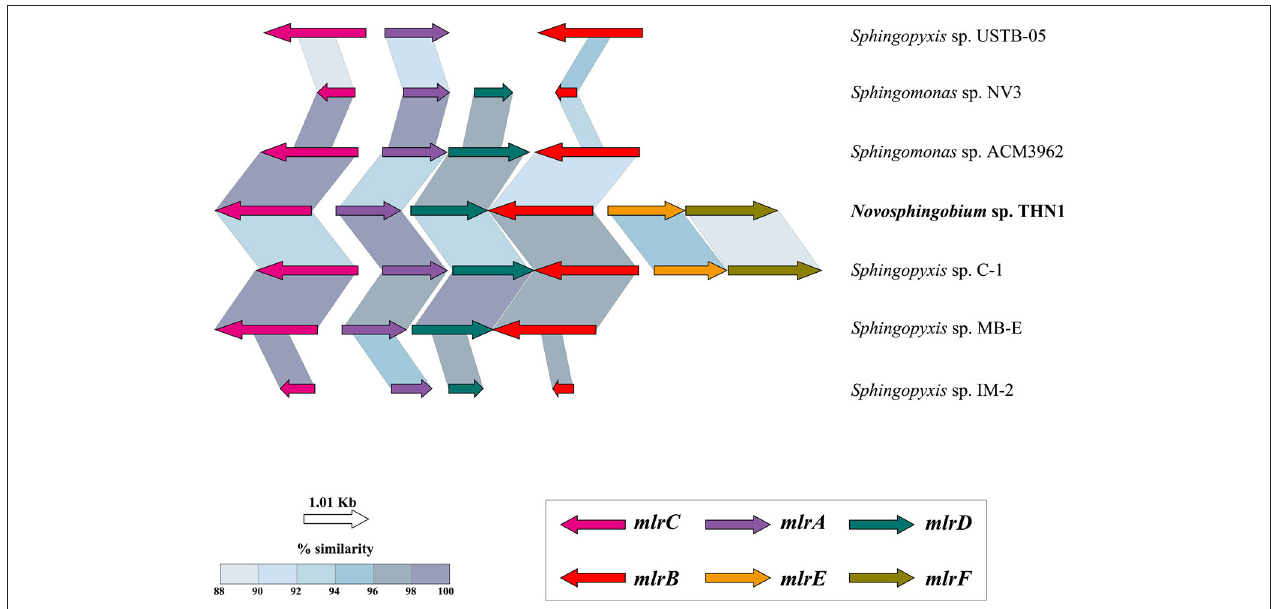
FIGURE 5 | Structure and similarity of the mlr gene cluster in THN1 and other species in family Sphingomonadaceae. TBLASTX was used to identify the mlr sequences and to determine similarities and alignment lengths. mlrA , mlrB , and mlrC encode proteins involved in the degradation of microcystins, and mlrD encodes a transporter protein. The functions of mlrE and mlrF are